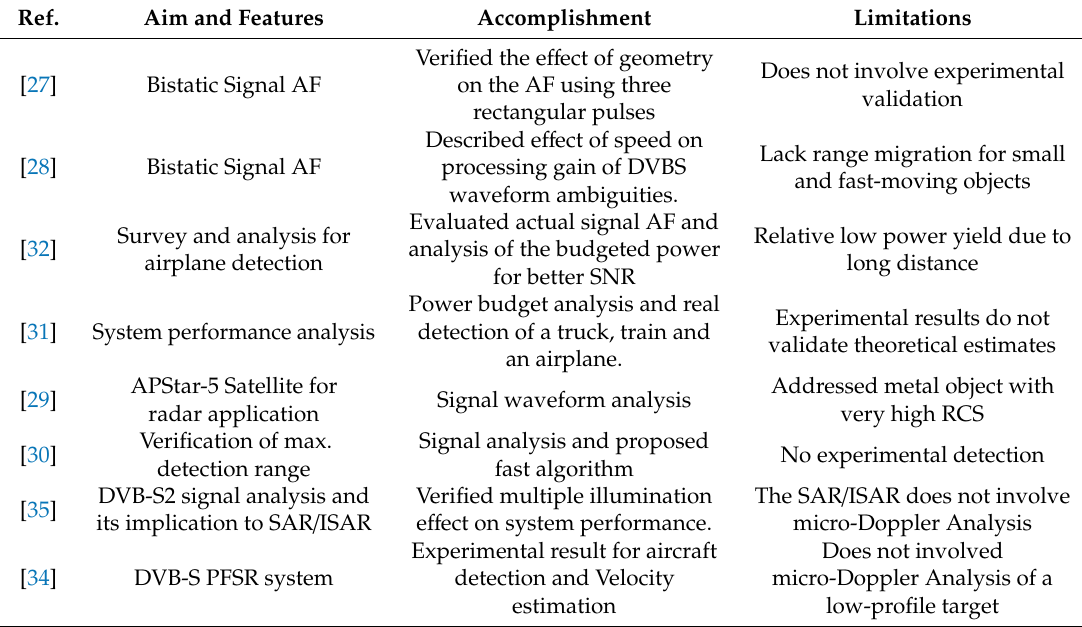
Table 2. DVB-S-based radars for airborne targets